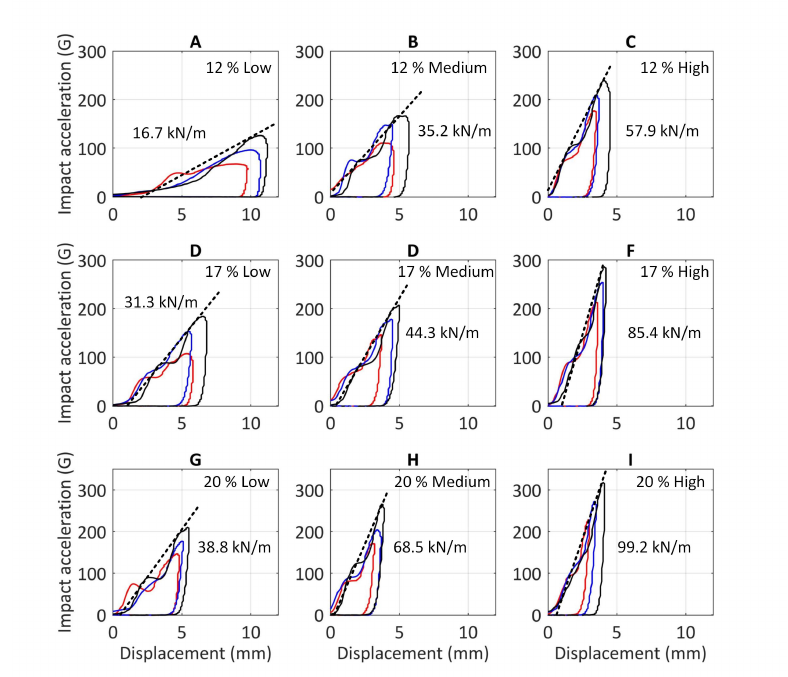
Figure 7. The load-deformation plots of the sand samples with different moisture levels and rates of compaction. The red, blue and black lines represent a drop height of 400 mm, 500 mm and 600 mm, respectively.